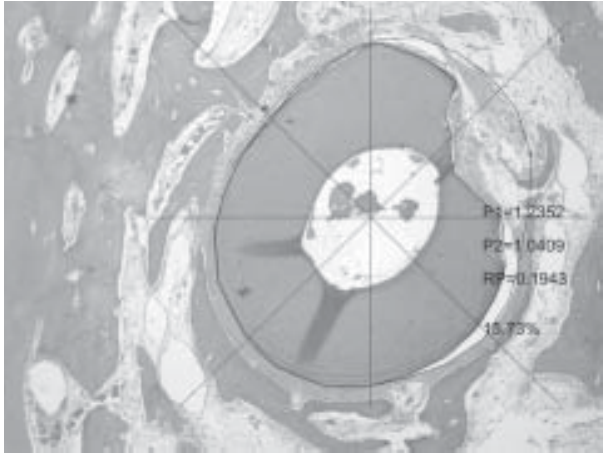
Fig.2 - Method of the measuring the root structure with Auto-cad program. Hematoxiylin and eosin